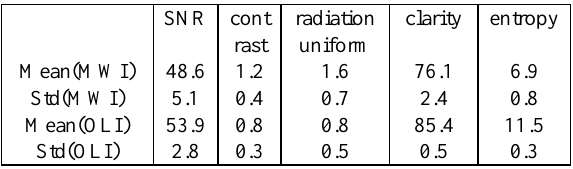
Table 5. Data quality evaluation results comparison between MWI and OLI in image of Dunhuang Desert radiation uniform